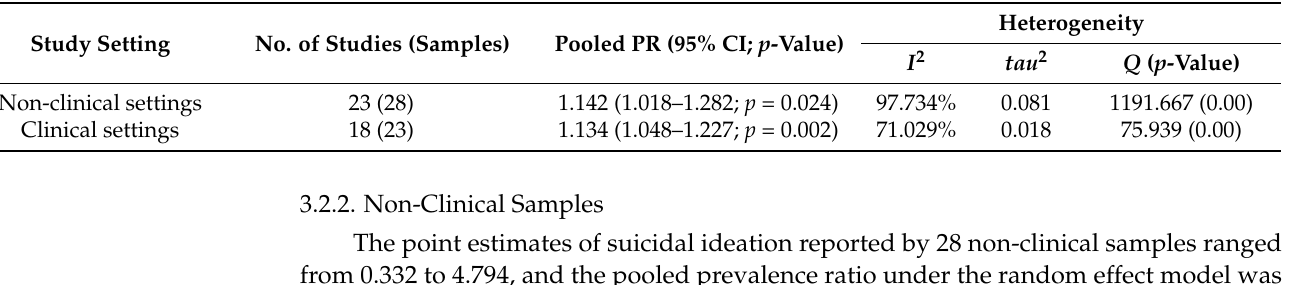
Table 3. Summary of meta-analysis results for studies reporting suicidal ideation in non-clinical and clinical